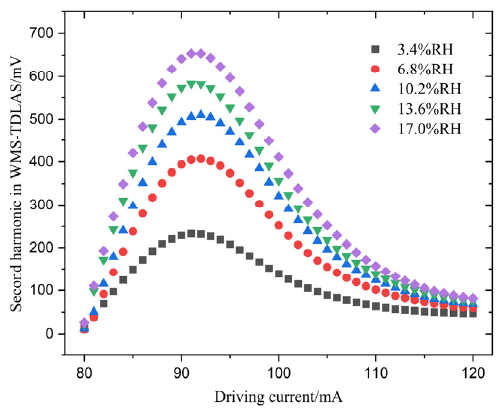
Figure 8. Second harmonic detection in the WMS-TDLAS mode.